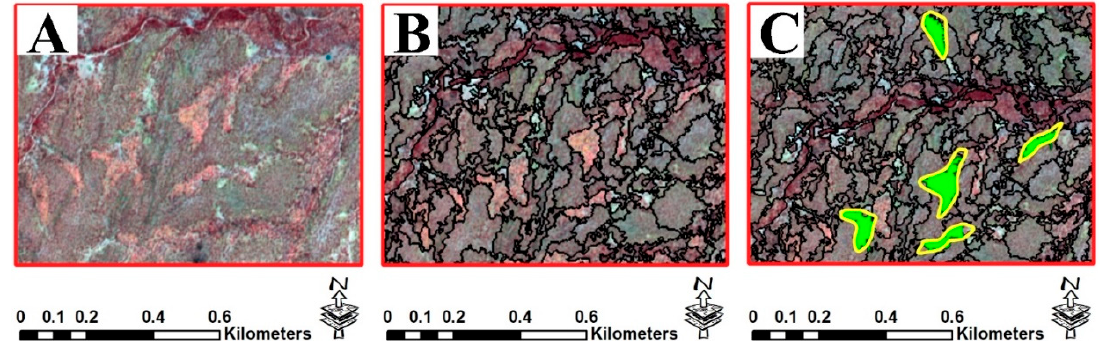
Figure 7. The selection process for image segmentation with scale of 45 and training samples. Part ( A ) is Sentinel 2A false-color composite, part ( B ) is a segmented image, and part ( C ) represents green polygons that are training objects. The yellow polygons are gully inventory maps.